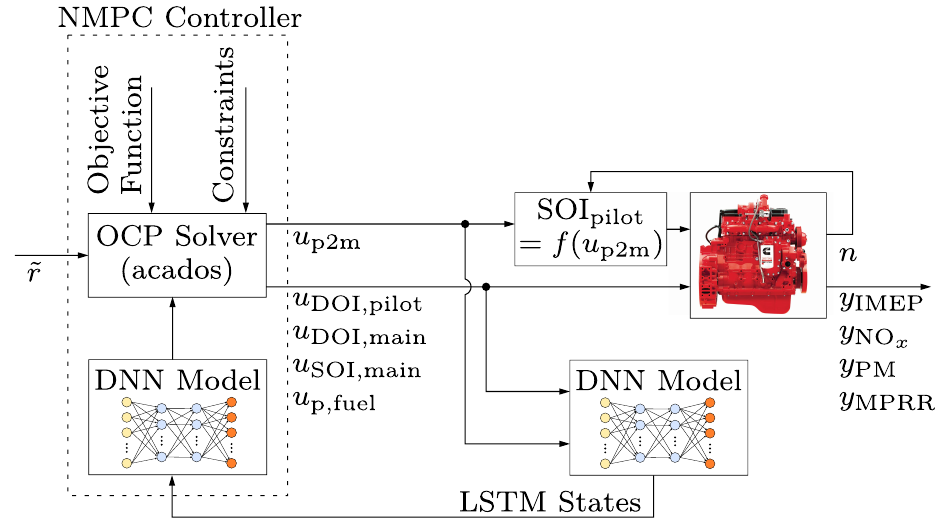
Figure 9. Block diagram of LSTM-NMPC structure—IMEP: indicated mean effective pressure, NO x : nitrogen oxides, PM: Particle Matter, MPRR: maximum pressure rise rate, n : engine speeds, DOI: duration of injection, SOI: start of